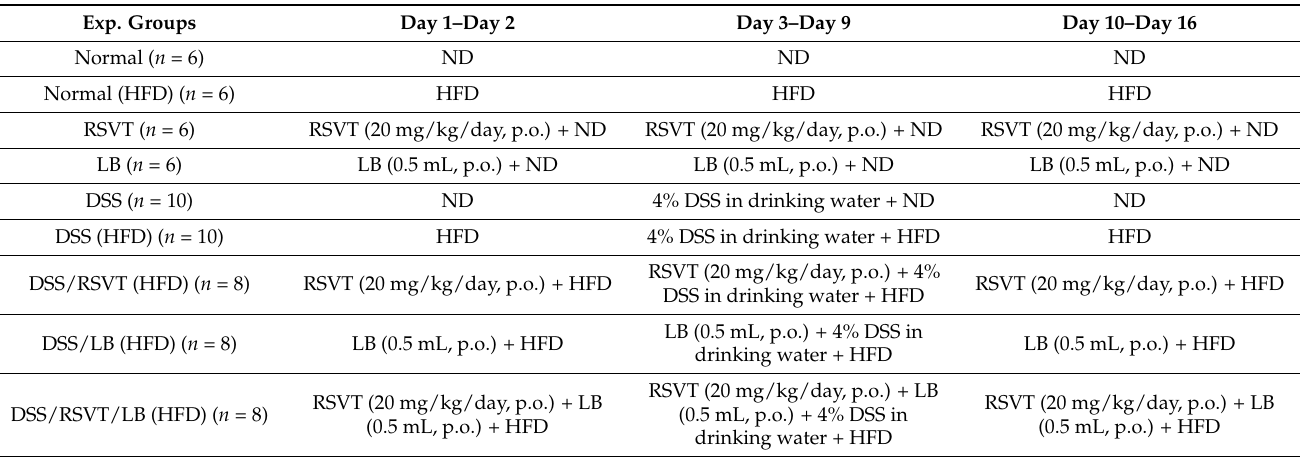
Table 2. Experimental design and treatment